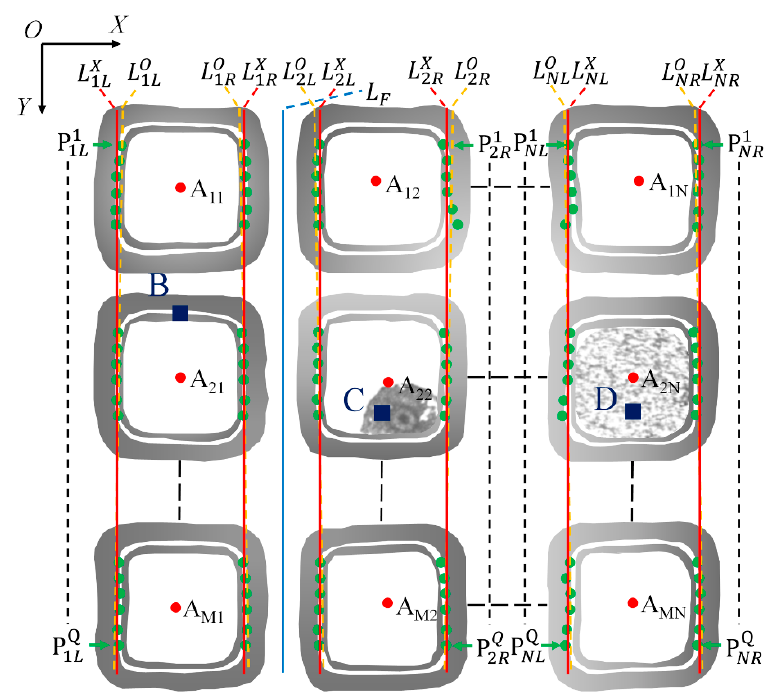
Figure 3. Definition of cutting path on the real wafer image.